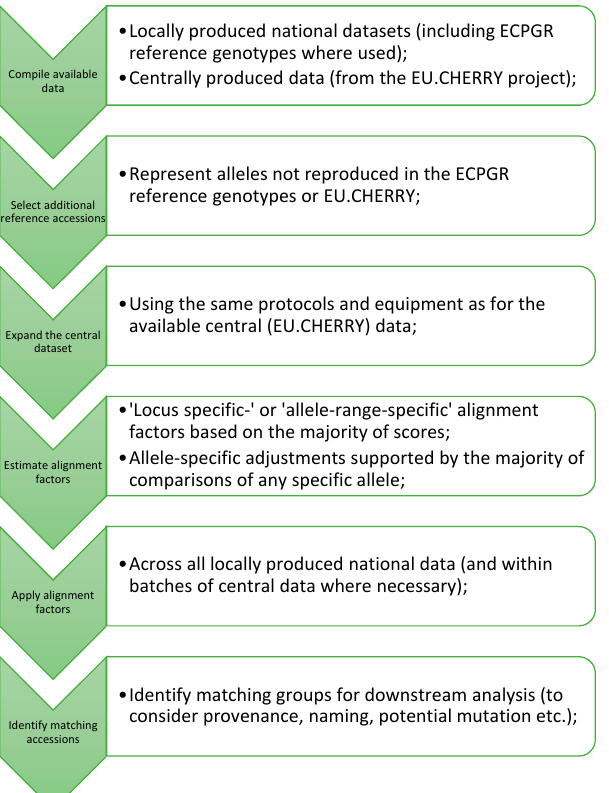
Figure 1. Summarised process for the alignment of datasets from national collections. Generic stages in the alignment process are listed in arrows with detail specific to our datasets and process expanded in the accompanying bullets.